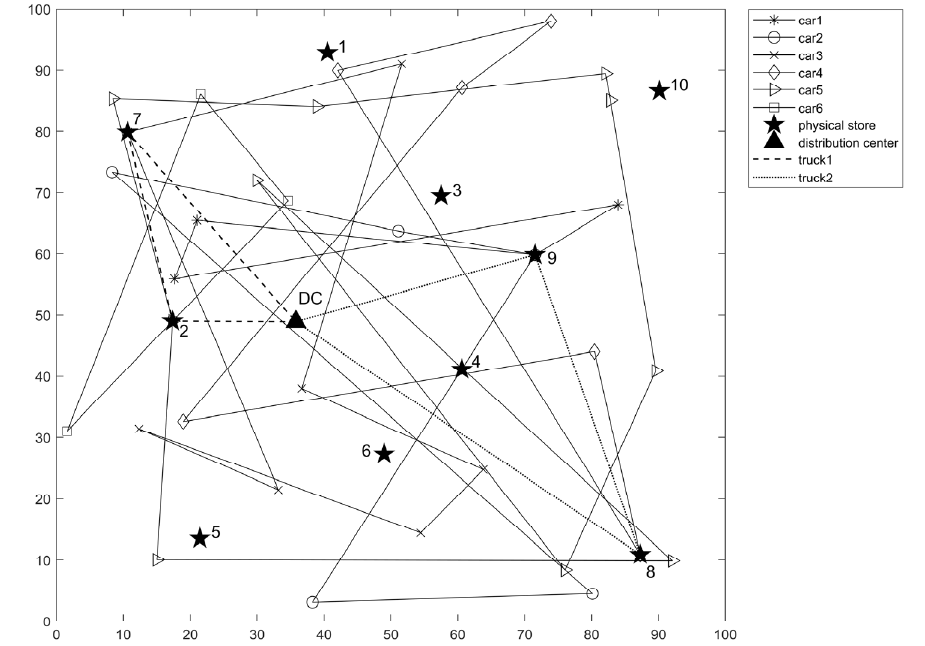
Figure 3. Schematic diagram of location and distribution route. Table 7. Optimization scheme of vehicle distribution route.